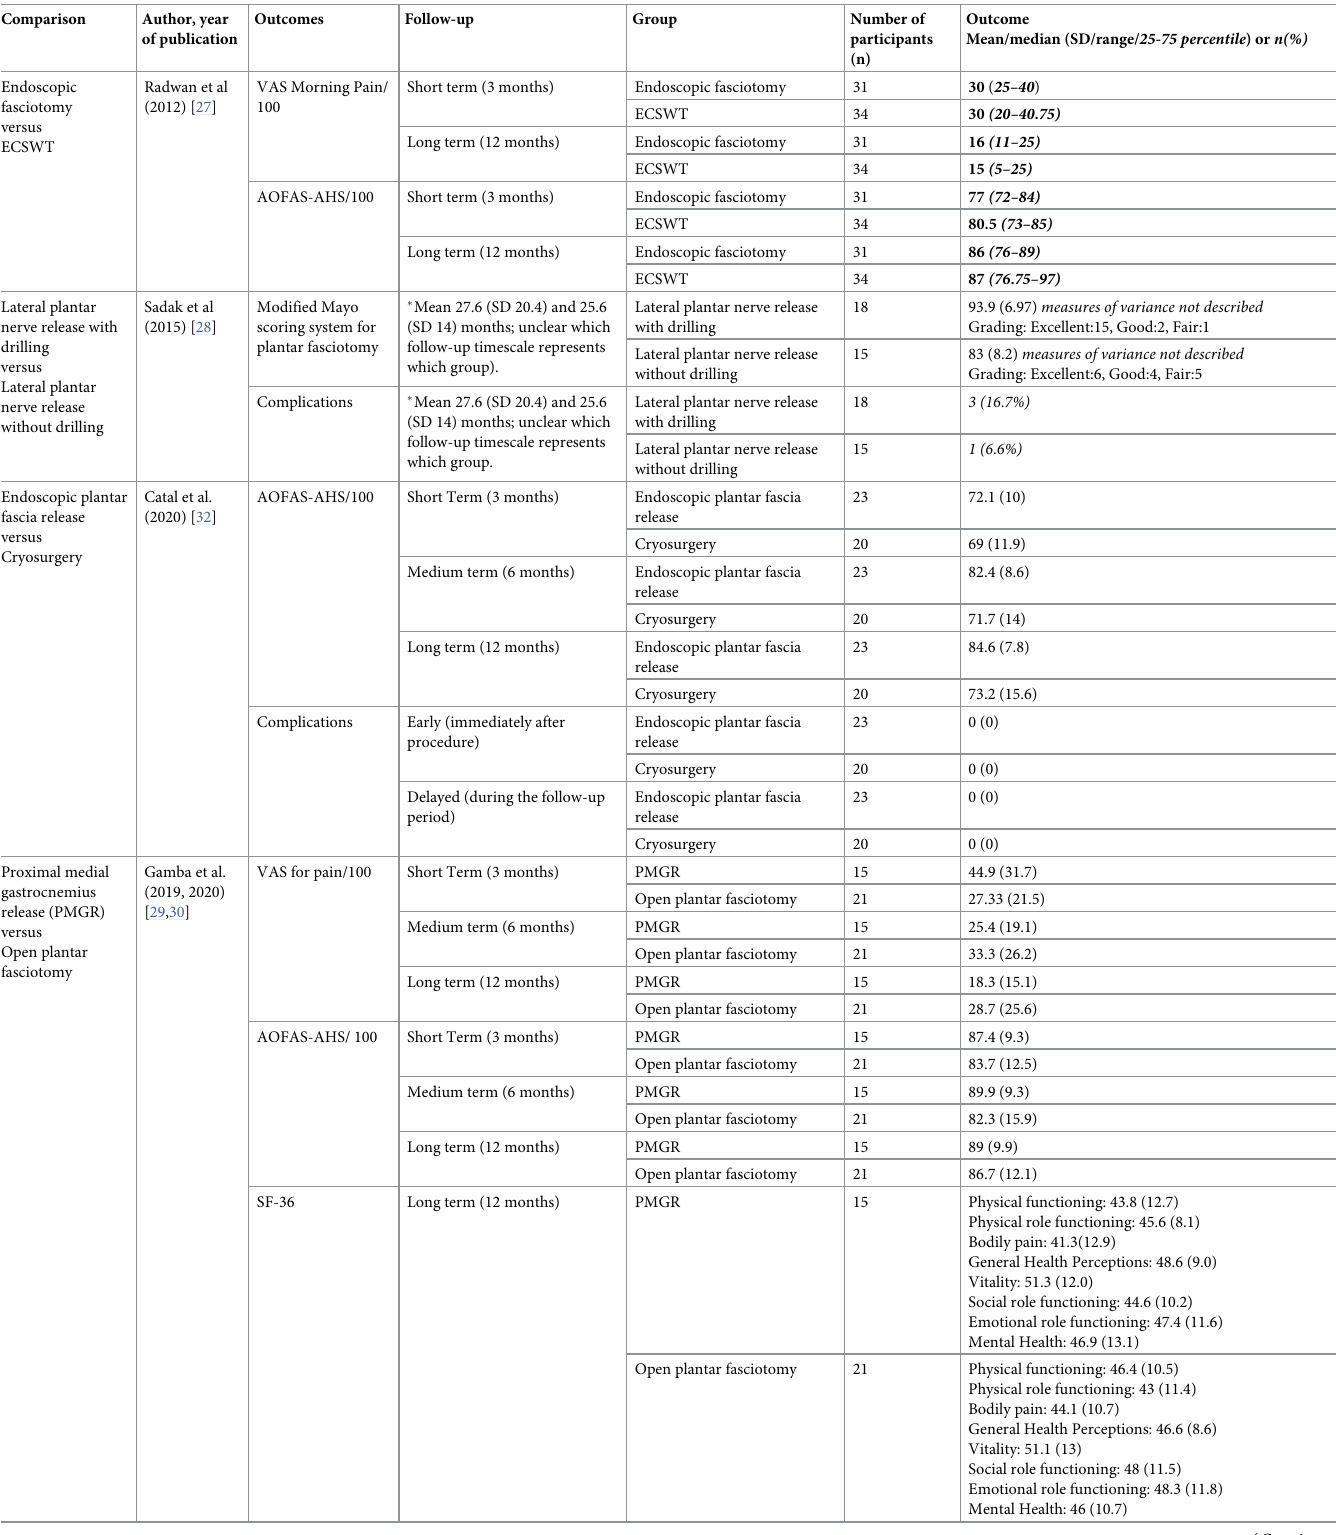
Openplantar fasciotomy Physical functioning:46.4(10.5)